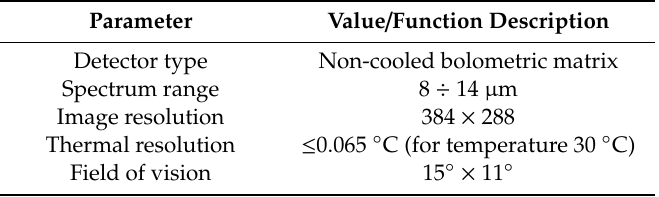
Table 1. Basic parameters of VIGOcam v50 camera (adapted from [32]).